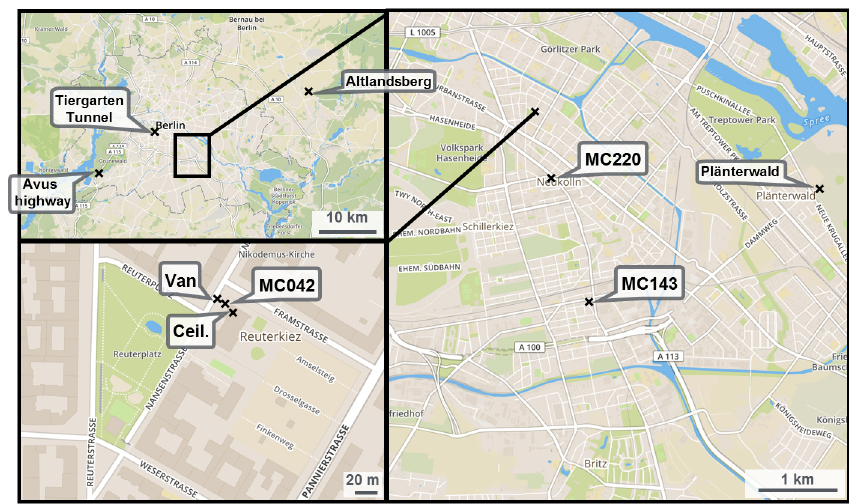
Figure 1. Location of the measurement station (MC042) and measurement van in Neukölln, Berlin. Maps show increasingly larger scale. The “x”s indicate sampling locations, with MC220 and MC143 indicating stations that record traffic counts. Map images from